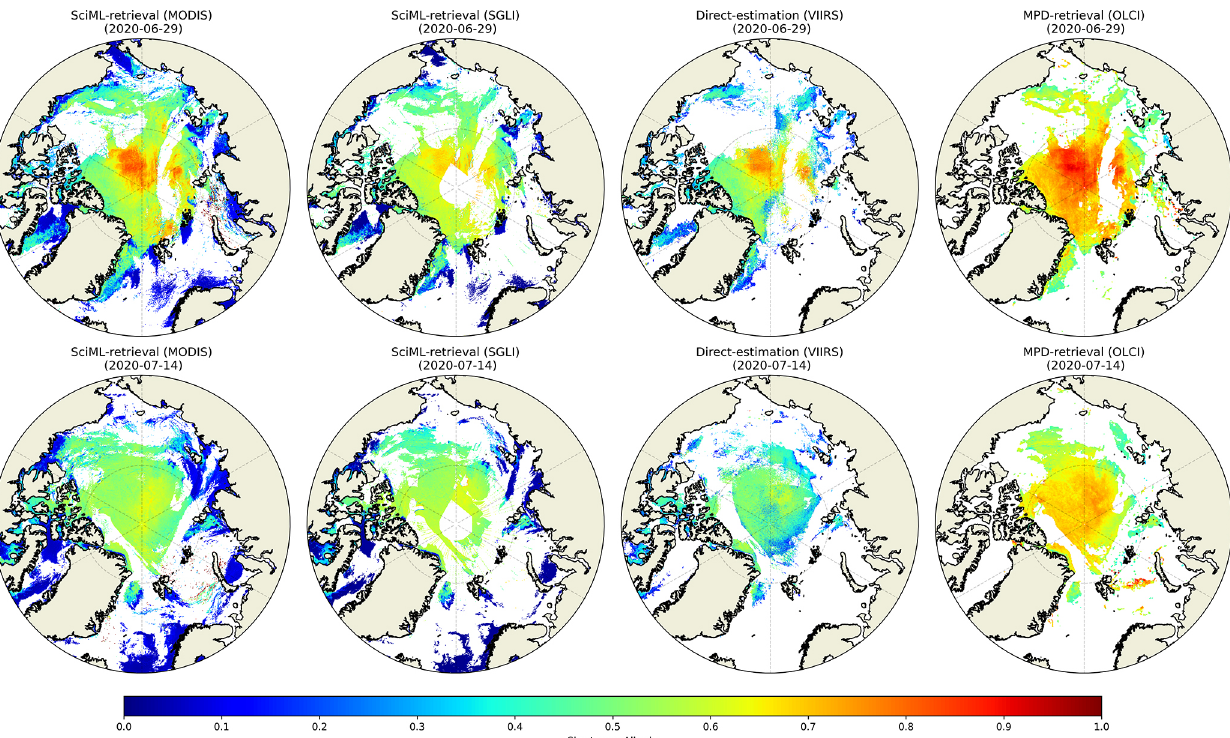
Figure 19. Pan-Arctic maps of albedo created using (from left to right) RTM–SciML (MODIS), RTM–SciML (SGLI), direct-estimation method (VIIRS), and MPD method (OLCI). The top row represents values for 29 June 2020, while the bottom row represents values for 14 July 2020. Empty regions in the SciML images represent cloud pixels that were detected by the MLCM cloud mask, whereas empty regions in VIIRS and OLCI images represent either cloud pixels or open-water areas that were not processed by the algorithms.